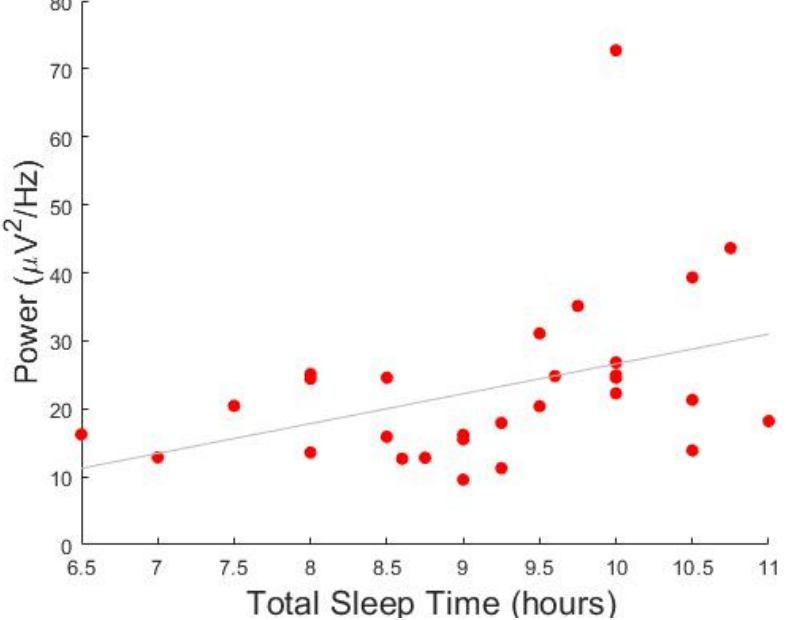
Figure 5. Correlation between power and total sleep time in children with attention deficit/hyper- activity disorder (ADHD). Y -axis represents the average power of all significant channels in the 3– 10 Hz cluster. X -axis represents the habitual total sleep time estimated by